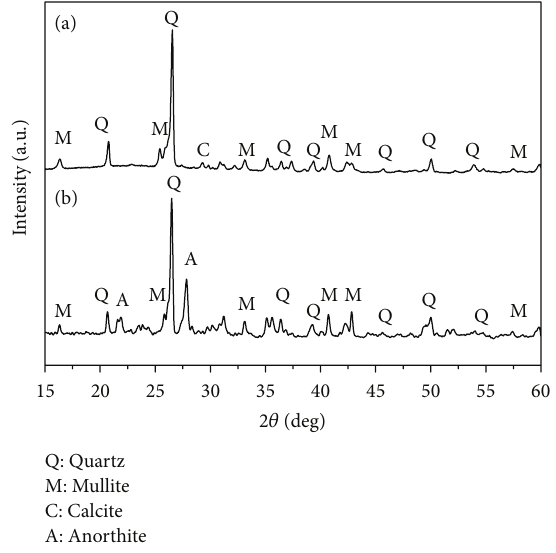
Figure 1: X-ray diffraction showing the main crystalline phases of (a) coal fly ash and (b) coal fly ash ceramic C318.